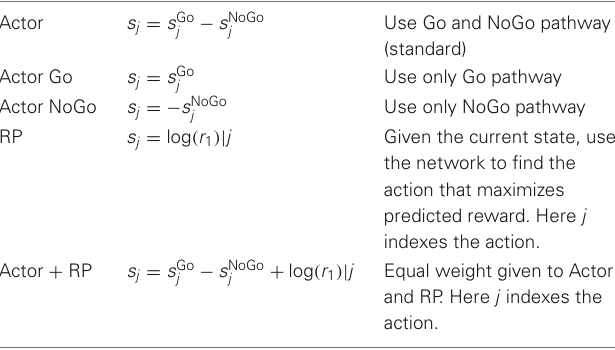
Table 1 | Specification of the different strategies to select an